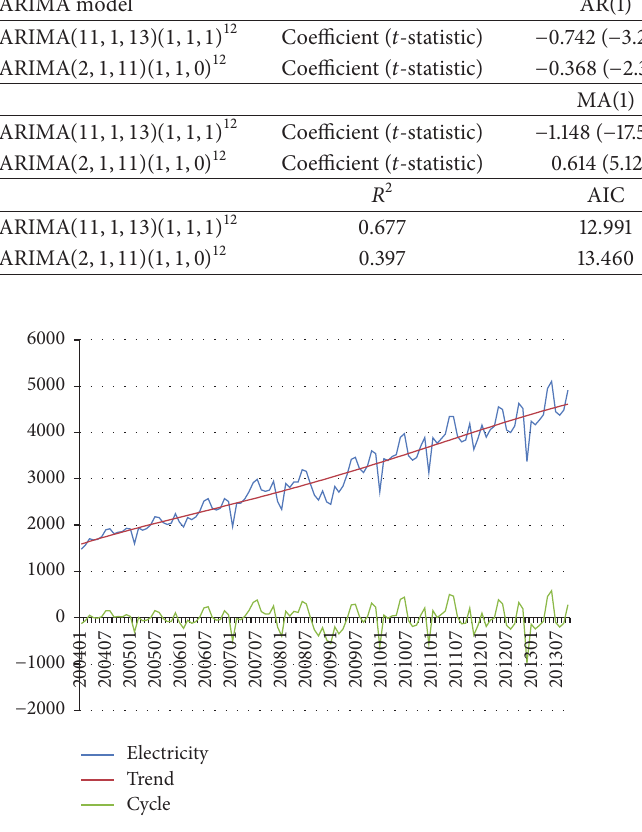
Figure 4: HP filter diagram of the power consumption.